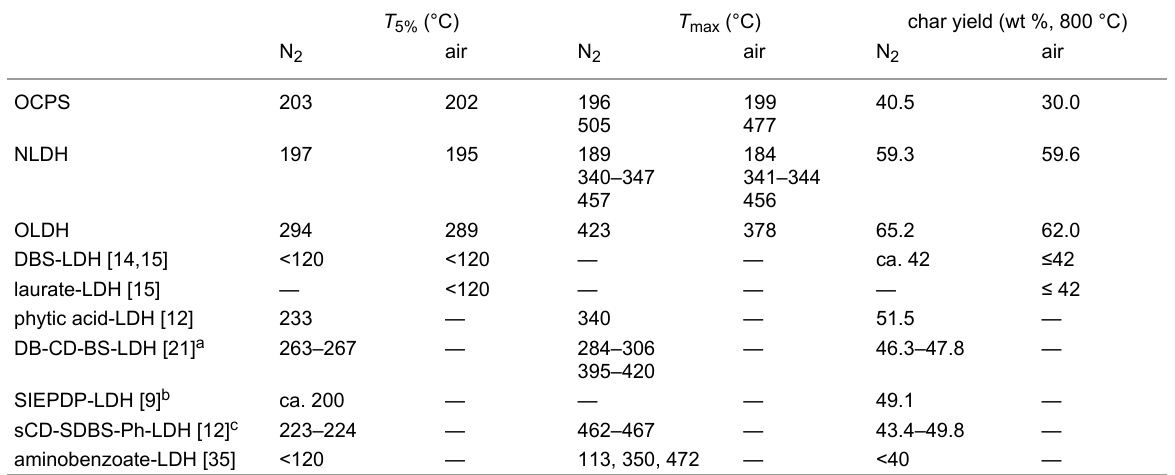
Table 3: Comparison of TG and DTG data between OCPS, NLDH, OLDH and other organically modified Mg–Al LDHs in N 2 and air. T 5%